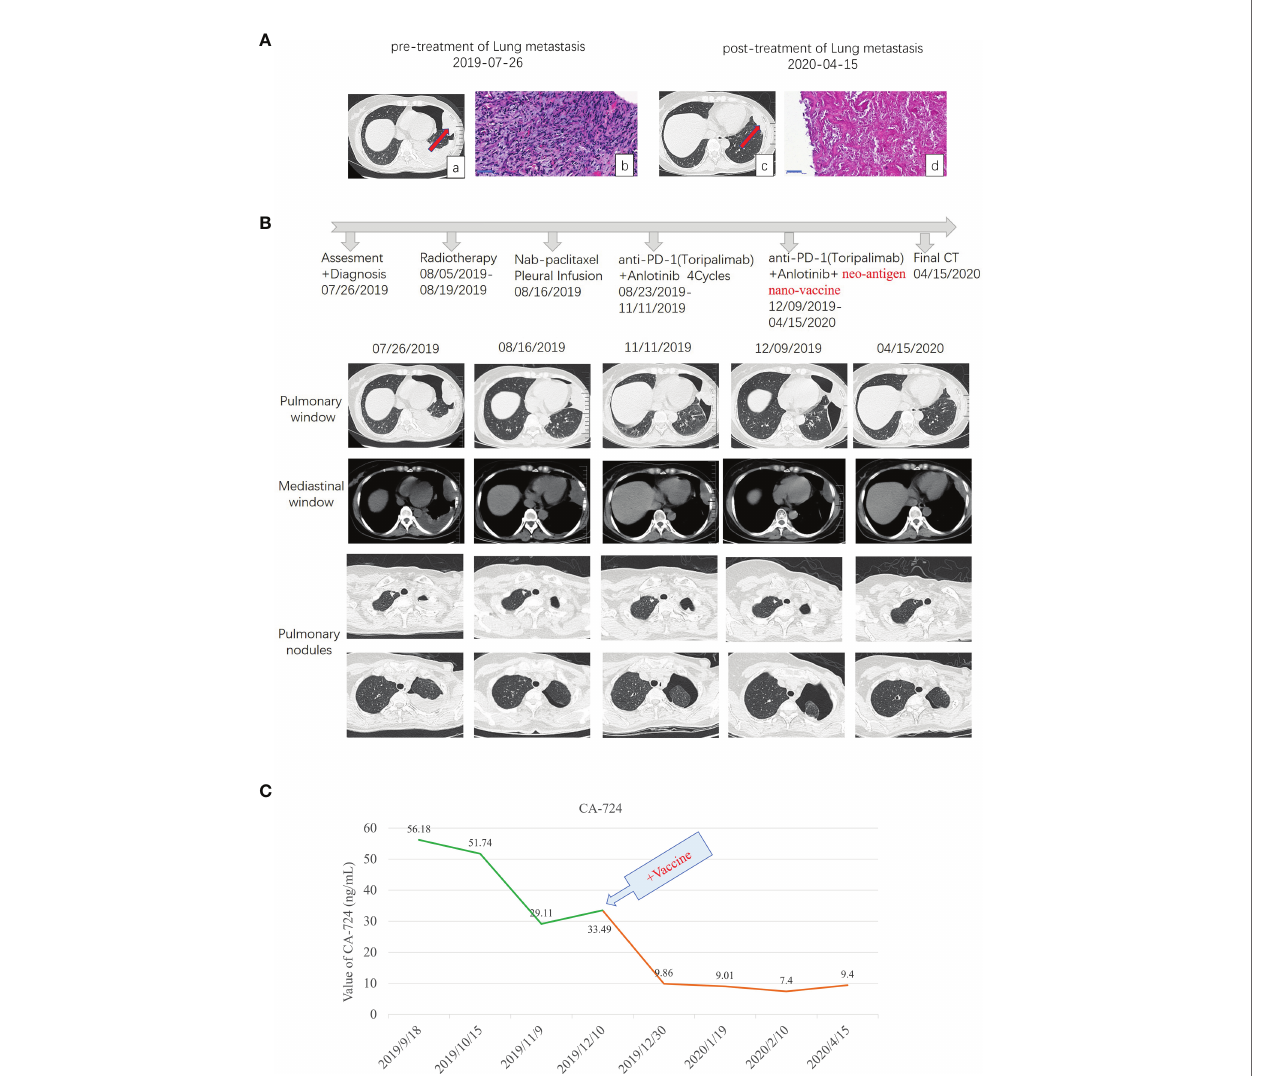
FIGURE 1 | Diagnostic assessment, treatment, and clinical monitoring of lung metastasis of phyllodes tumor patient. (A) Pretreatment and posttreatment assessment of lung metastasis, as determined by chest CT scans (a, c) and pathological examination of H&E-stained needle biopsies (b, d) . Bar = 50 m m. (B) Timeline indicating treatment dates of radiotherapy, intraperitoneal chemotherapy of albumin paclitaxel, anti-PD1 combined with anlotinib treatment, and the addition of the multi-epitope peptide neoantigen nano-vaccine. The corresponding chronological series of the pulmonary window and mediastinal window CT scans are shown. Some other small lung nodules gradually vacuolated (shown in B pulmonary nodules). (C) The dynamic changes of the tumor marker CA-724 with time are